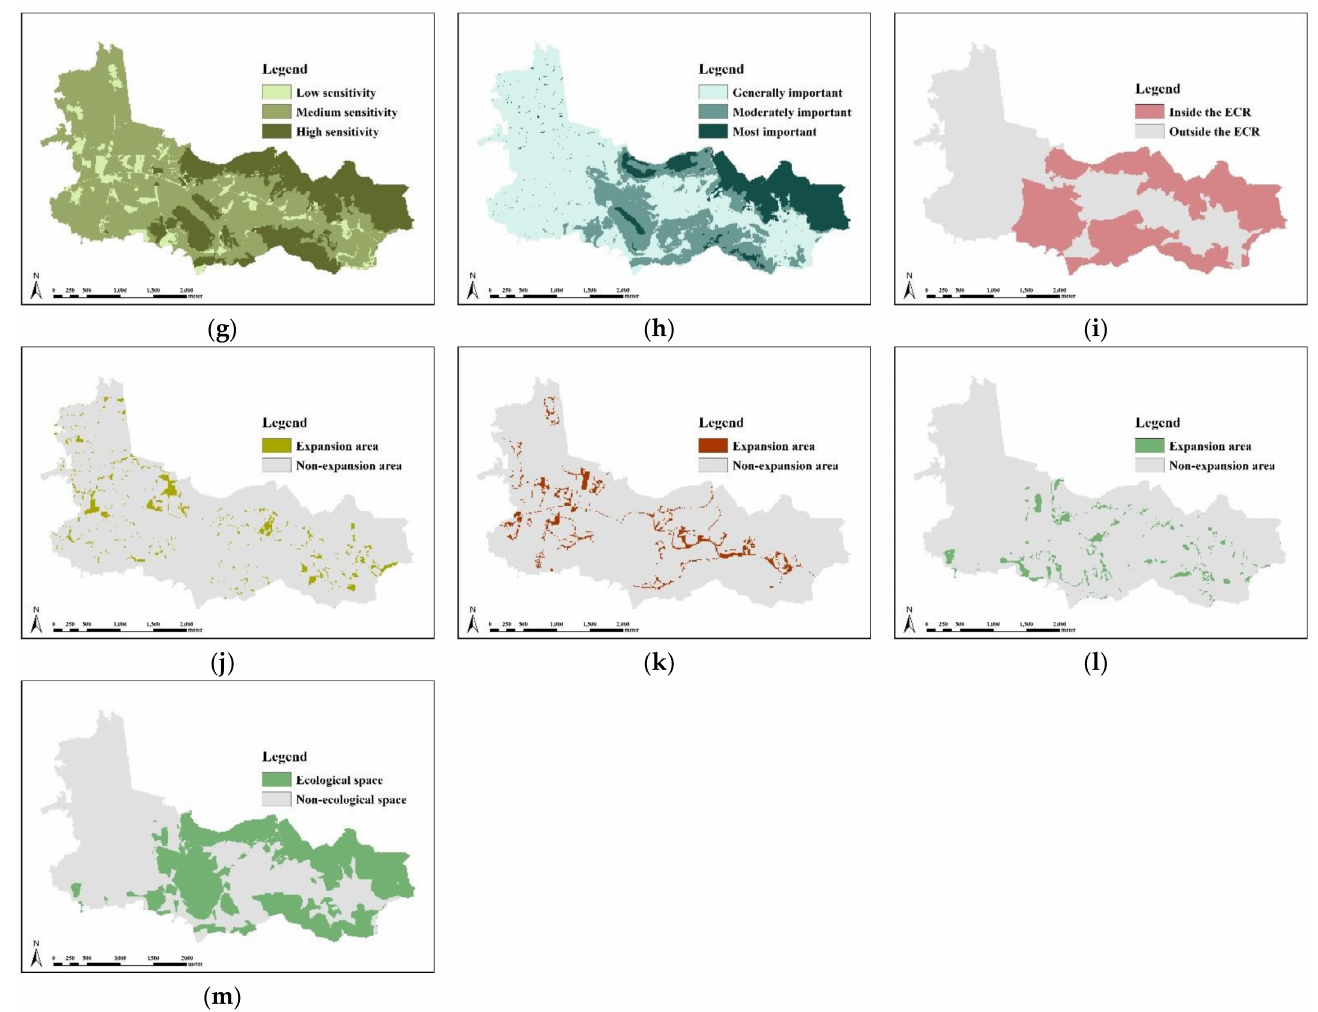
Figure 6. Discrete training sample data. ( a ) Altitude; ( b ) Slope; ( c ) Distance from water (2010); ( d ) Distance from roads (2010); ( e ) Distance from buildings (2010); ( f ) Distance from woodland (2010); ( g ) Ecological sensitivity (2010); ( h ) Importance of SEV (2010); ( i ) ECR; ( j ) Agricultural expansion (2010–2020); ( k ) Construction expansion (2010–2020); ( l ) Ecological expansion (2010–2020); ( m ) Ecological space (2020).